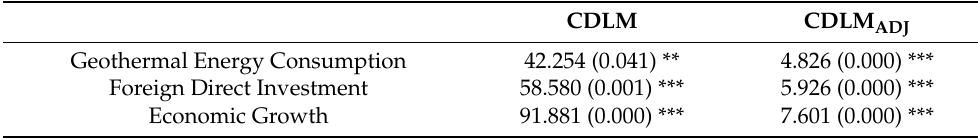
Table 3. Cross-section dependency test results.